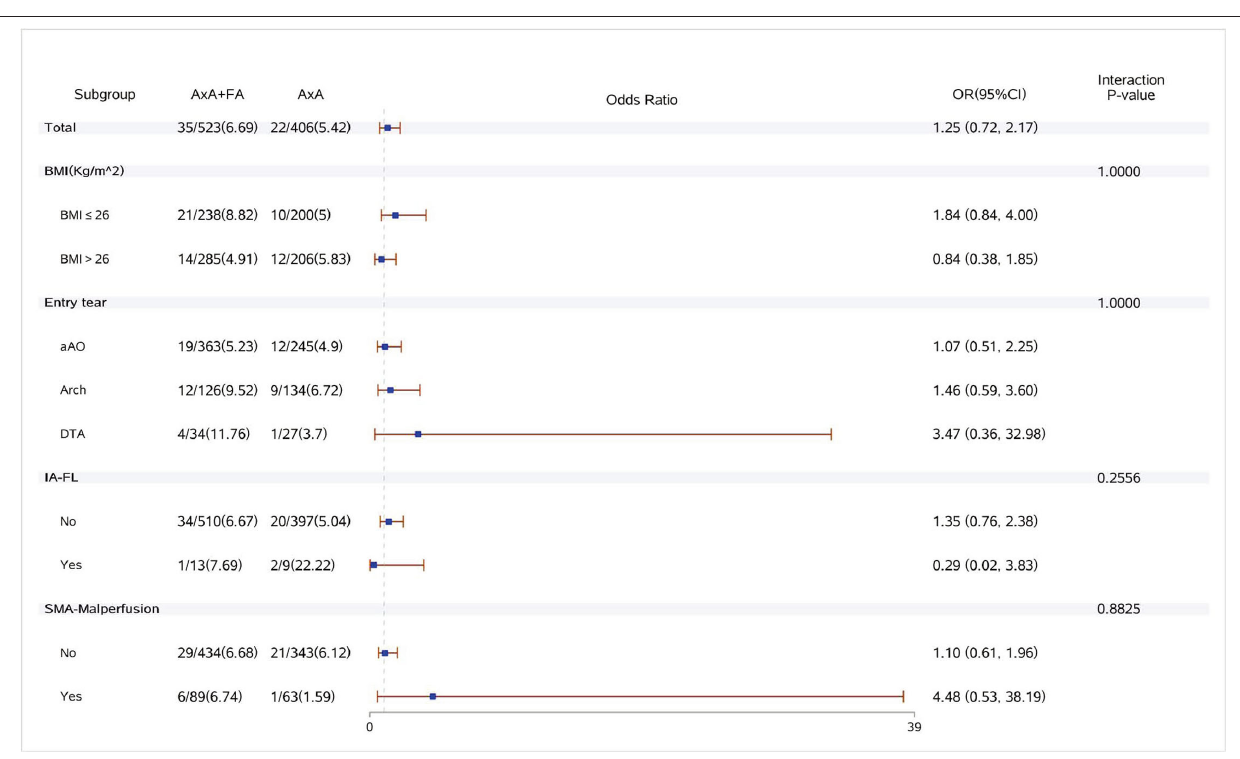
FIGURE 2 | Forest plot of dual arterial cannulation vs. axillary artery cannulation regarding stroke by subgroups. AXA + FA, axillary artery cannulation + femoral artery cannulation; AXA, axillary artery cannulation; IA-FL, innominate artery originating from false lumen; and SMA, superior mesenteric